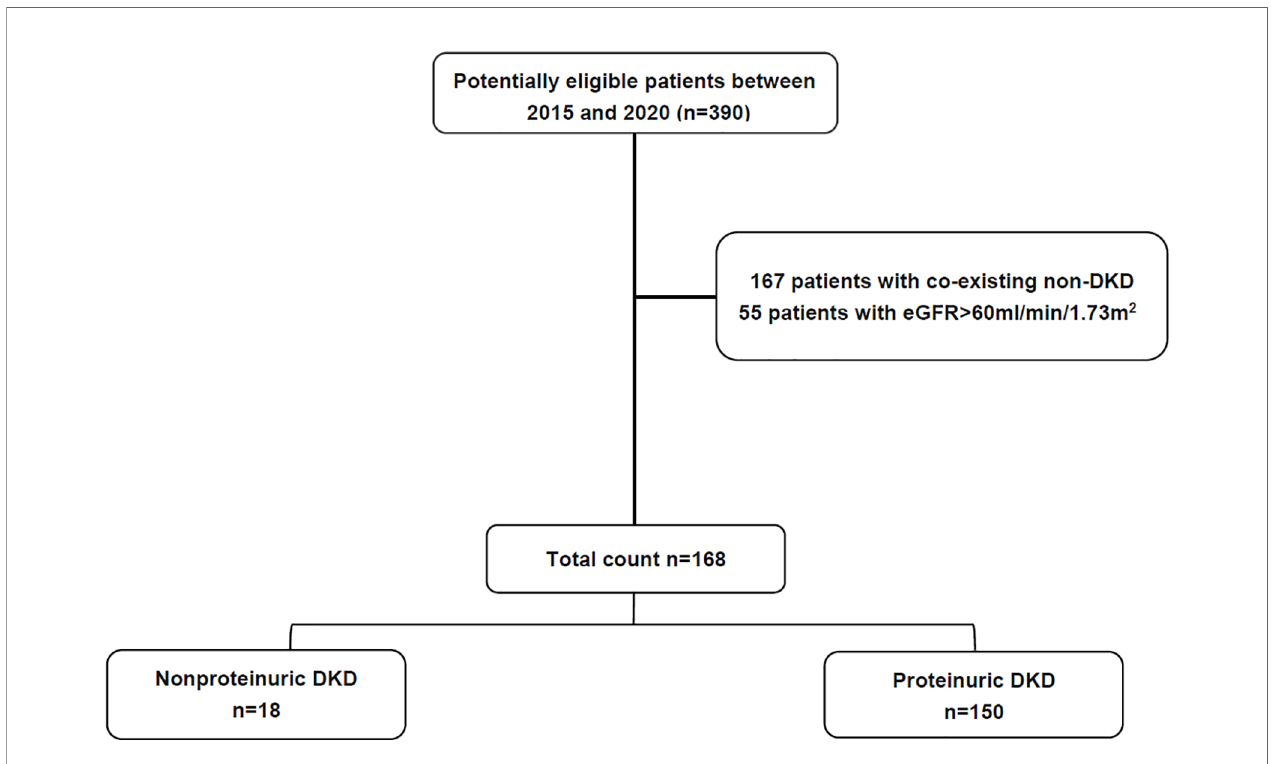
FIGURE 1 | Flowchart for